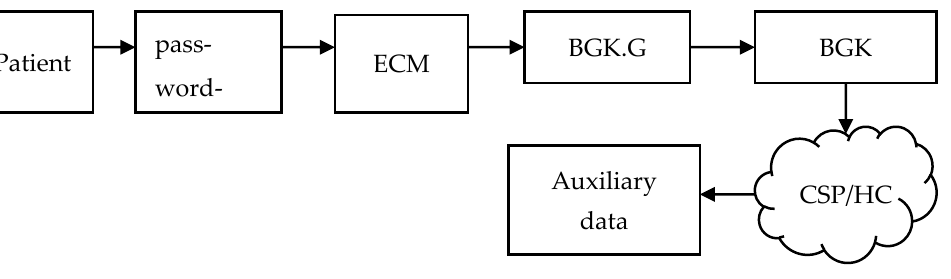
Figure 3. Break-glass key (BGK) generation.